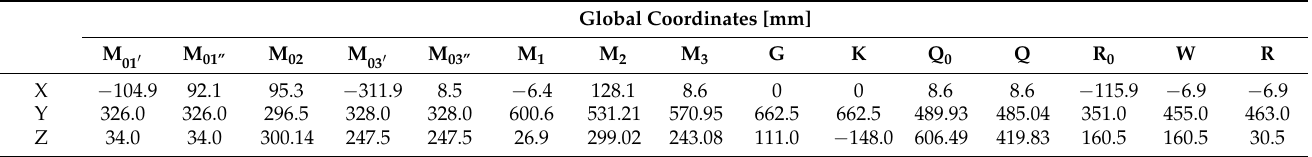
Table 1. The design points defining the wheel suspension mechanism. Global Coordinates